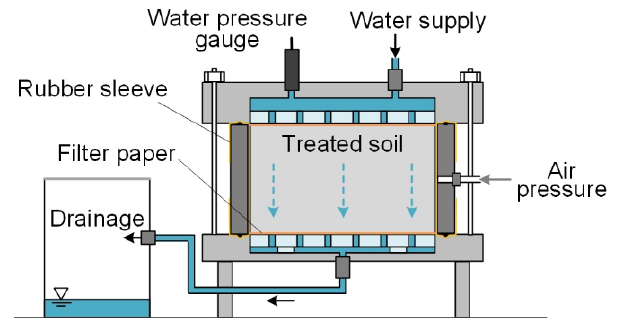
Figure 15. Schematic view of test